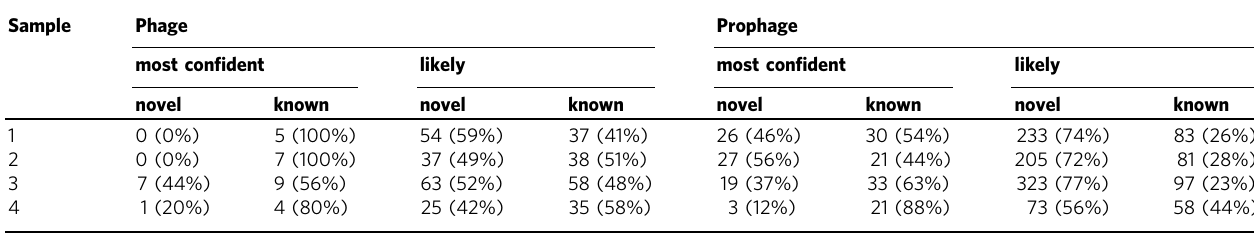
Table 1 The number and proportion of viral sequences identi fi ed in each sample and strati fi ed by the “ most con fi dent ” and “ likely ” phages and